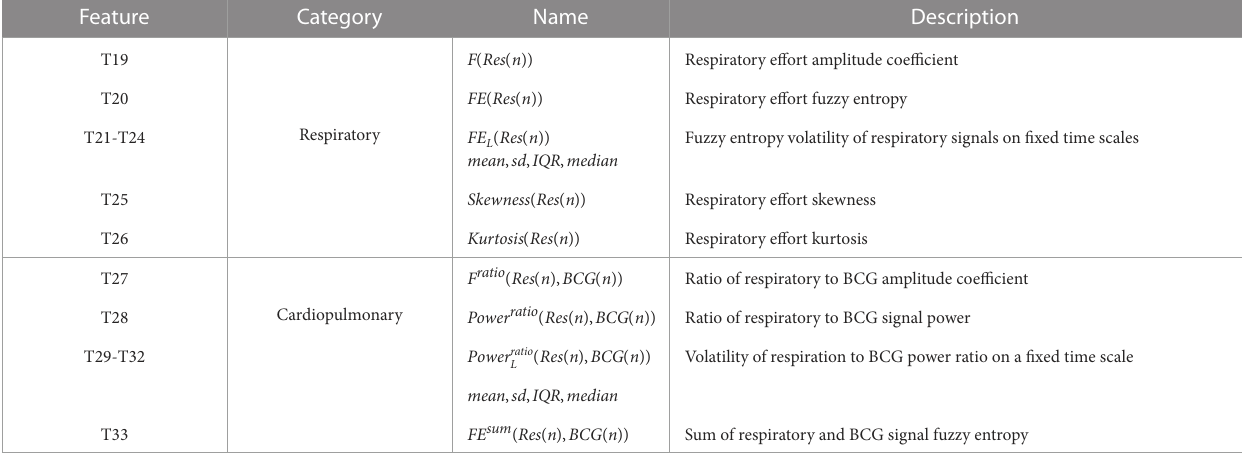
TABLE3 Respiratoryandcardiopulmonaryfeatures.sd:standarddeviation.IQR:interquartilerange.